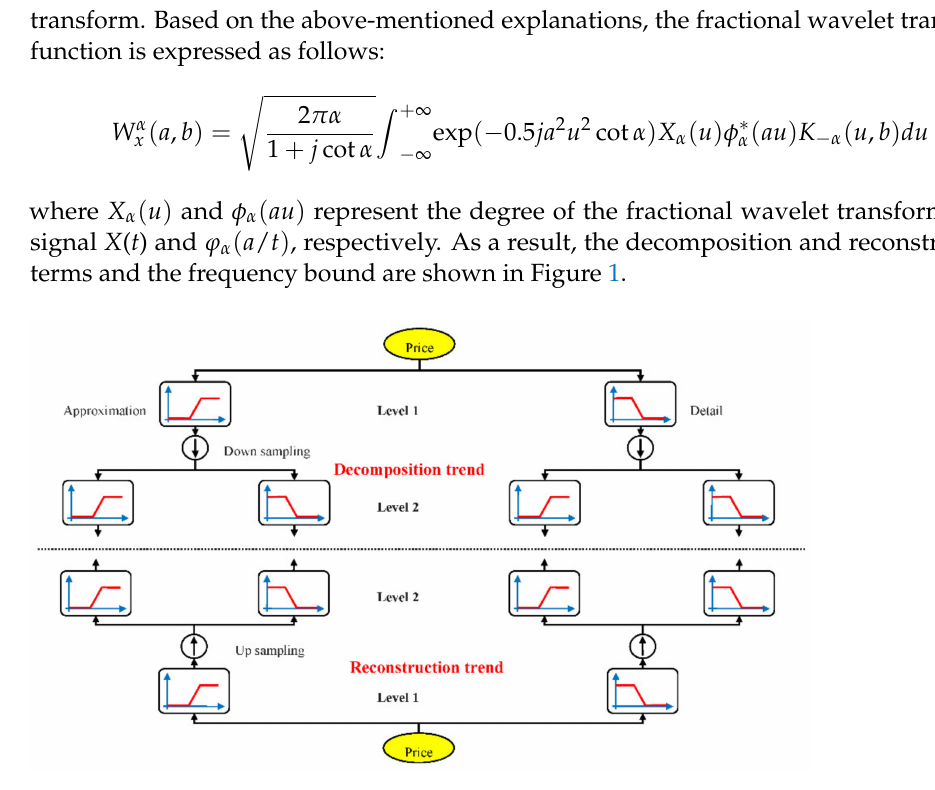
Figure 1. The overview of proposed wavelet transform decomposition and reconstruction tree at two